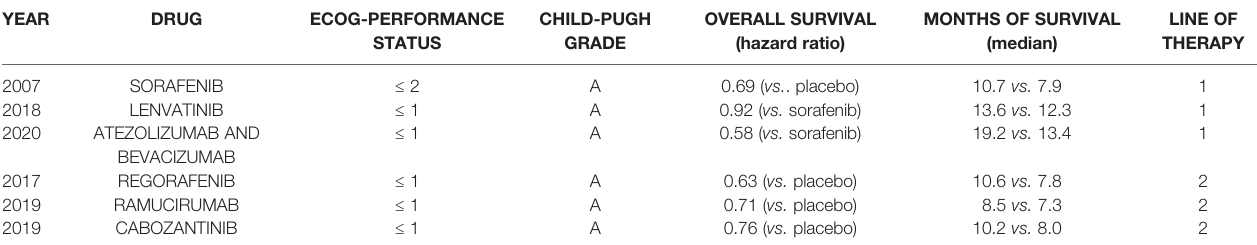
TABLE 1 | Overall survival and median survival periods from 6 phase 3 trials in which overall survival was the primary end-point of ef fi